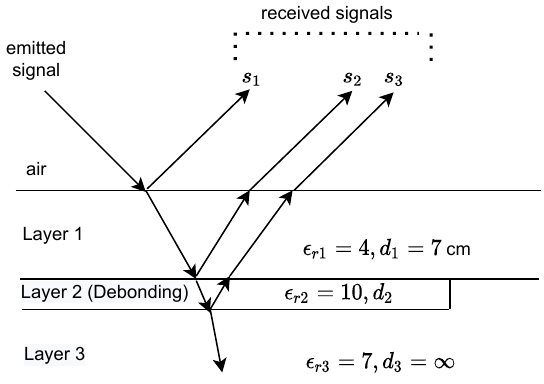
Figure 1. Layered pavement structure with debonding (on the